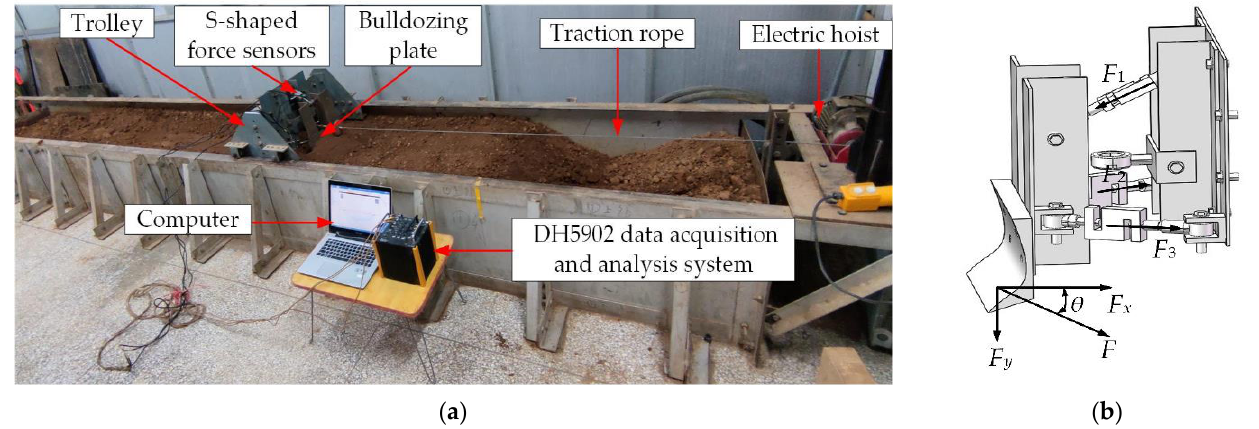
Figure 10. The t est system of soil cutting resistance . ( a ) Live photos of test work. ( b ) Schematic Figure 10. The test system of soil cutting resistance. ( a ) Live photos of test work. ( b ) Schematic diagram of the force measuring device. diagram of the force measuring